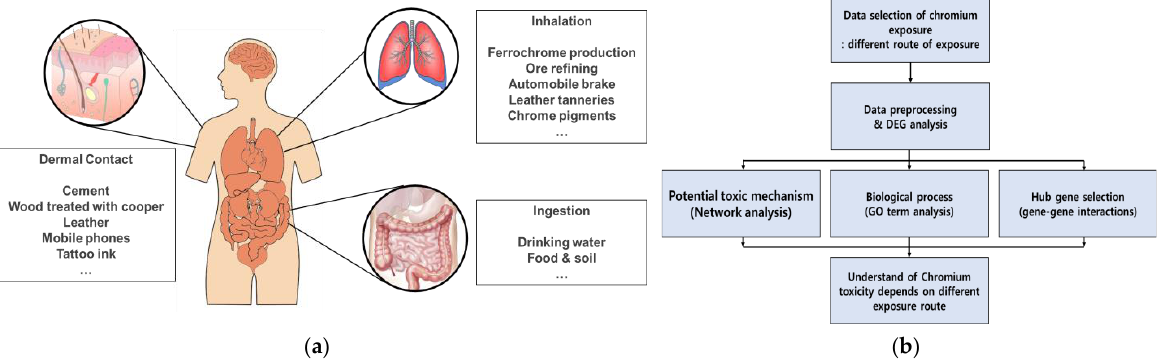
Figure 1. ( a ) Sources of Cr exposure based on different exposure paths. ( b ) Flow chart of the steps used in this review.